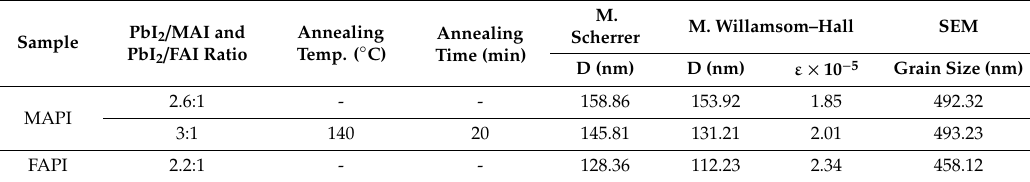
Table 2. Influence of the PbI 2 /MAI (and PbI 2 /FAI) thickness ratio and post deposition annealing